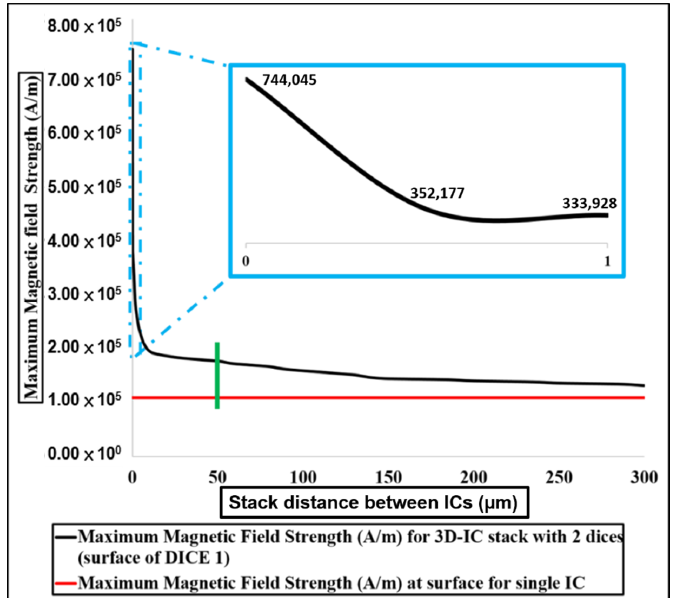
Figure 11. Maximum magnetic field strength versus the distance between the layers of 2D-3D-IC at 3 GHz operating frequency.